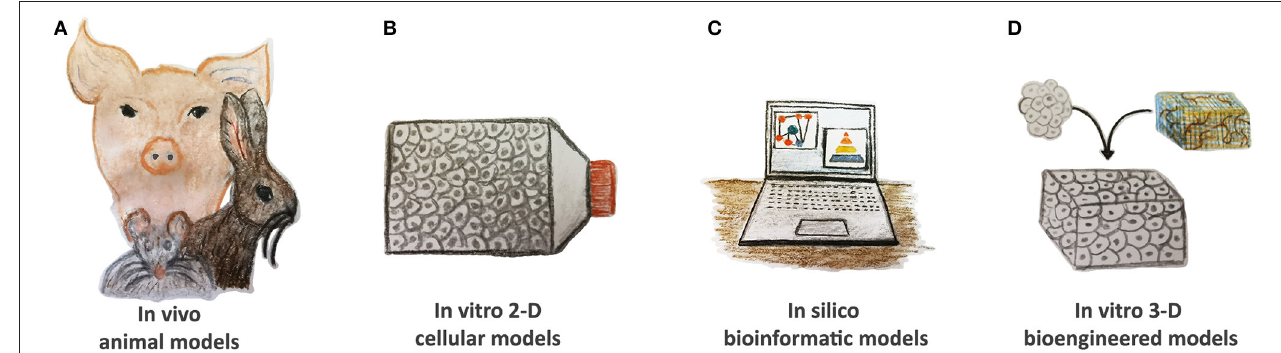
FIGURE 2 | Current tools of CVDs modeling. (A) In vivo animal models, such as rodents, rabbits, and pigs, have been widely used to study CVD pathomechanisms; however, they display many anatomical and physiological differences when compared to humans. (B) In vitro two-dimensional (2-D) cellular models based on animal and human cells as well as on pluripotent stem cells demonstrate their validity to evaluate the altered pathway at the single-cell level. (C) In silico bioinformatic tools gather together all the information and knowledge generated in other models, consider stratification risks, and advance new hypotheses. Reproducible validation is compulsory. (D) In vitro 3-D bioengineered models are gaining more interest in the cardiovascular research community by offering human platforms for CVD modeling in precision medicine settings. They might also be applied to verify the therapeutic hypotheses of in silico